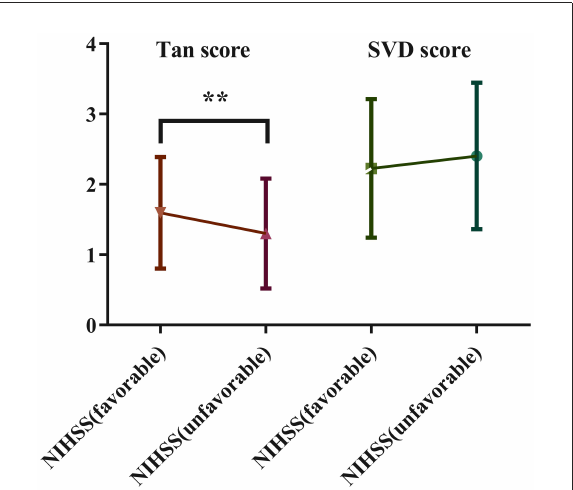
FIGURE3 Comparison of the Tan score and SVD score between the two groups stratified based on the NIHSS score.